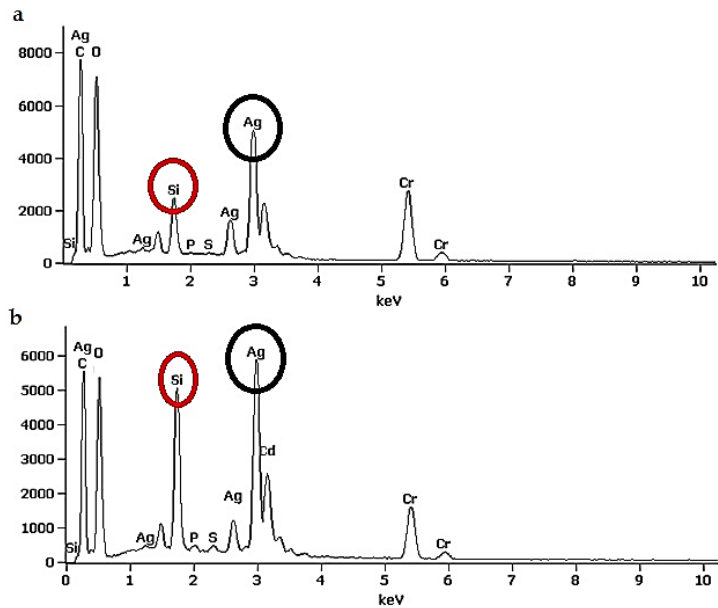
Figure 9. EDS spectra of synthesized nanohybrid (Ag-SiO 2 ) by G. flavovirens ( a ) and G. mutabilis ( b ). Spectra ( a , b ) showing presence of Ag and Si both signals in a single point of synthesized particles and confirming production of Ag-SiO 2 nanohybrid. Materials 2021 , 14 , x FOR PEER REVIEW